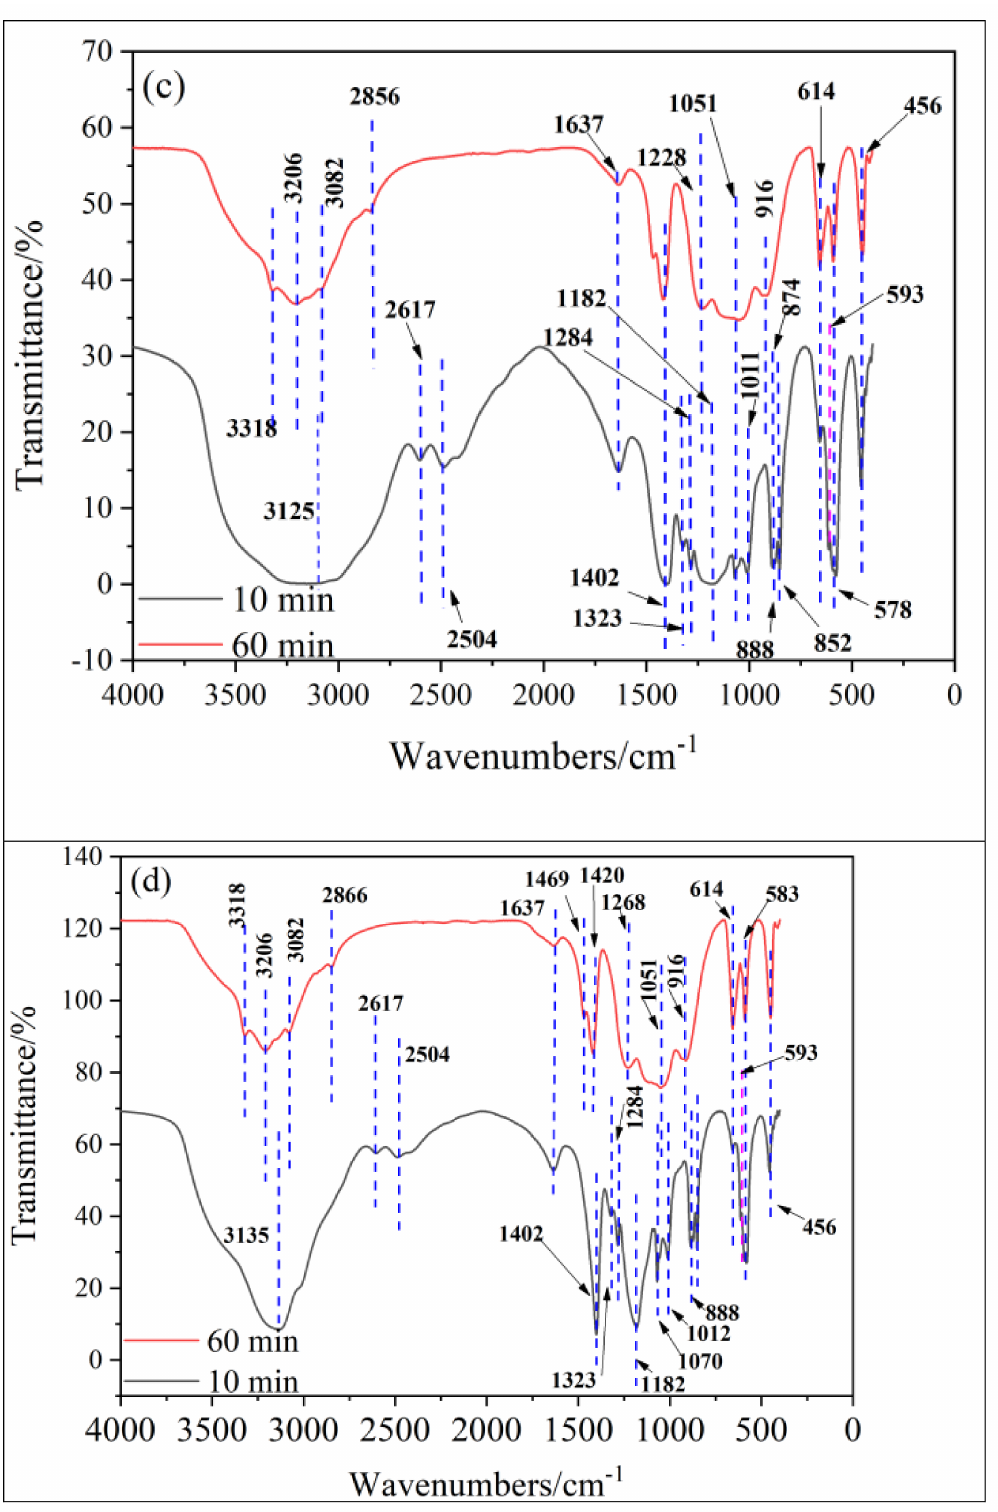
Figure 3. FT − IR analysis of ( a ) raw slag, ( b ) roasted slag in the air, ( c ) roasted slag + ABS in N 2 gas, ( d ) roasted slag + ABS in